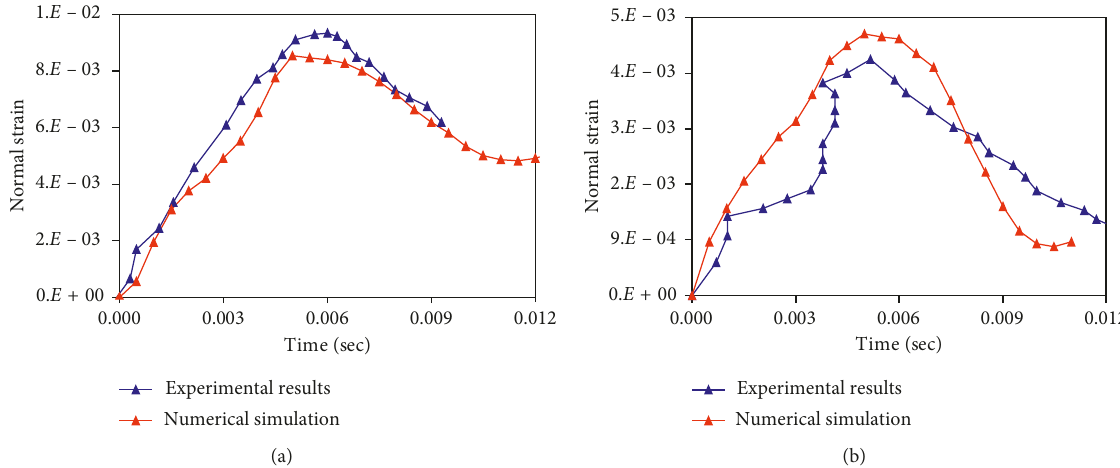
Figure 5: Comparison of the strain time histories of the steel columns 4C1 (a) and 5C1 (b) between the experimental tests of Nassr et al. [4] and the present numerical simulation.